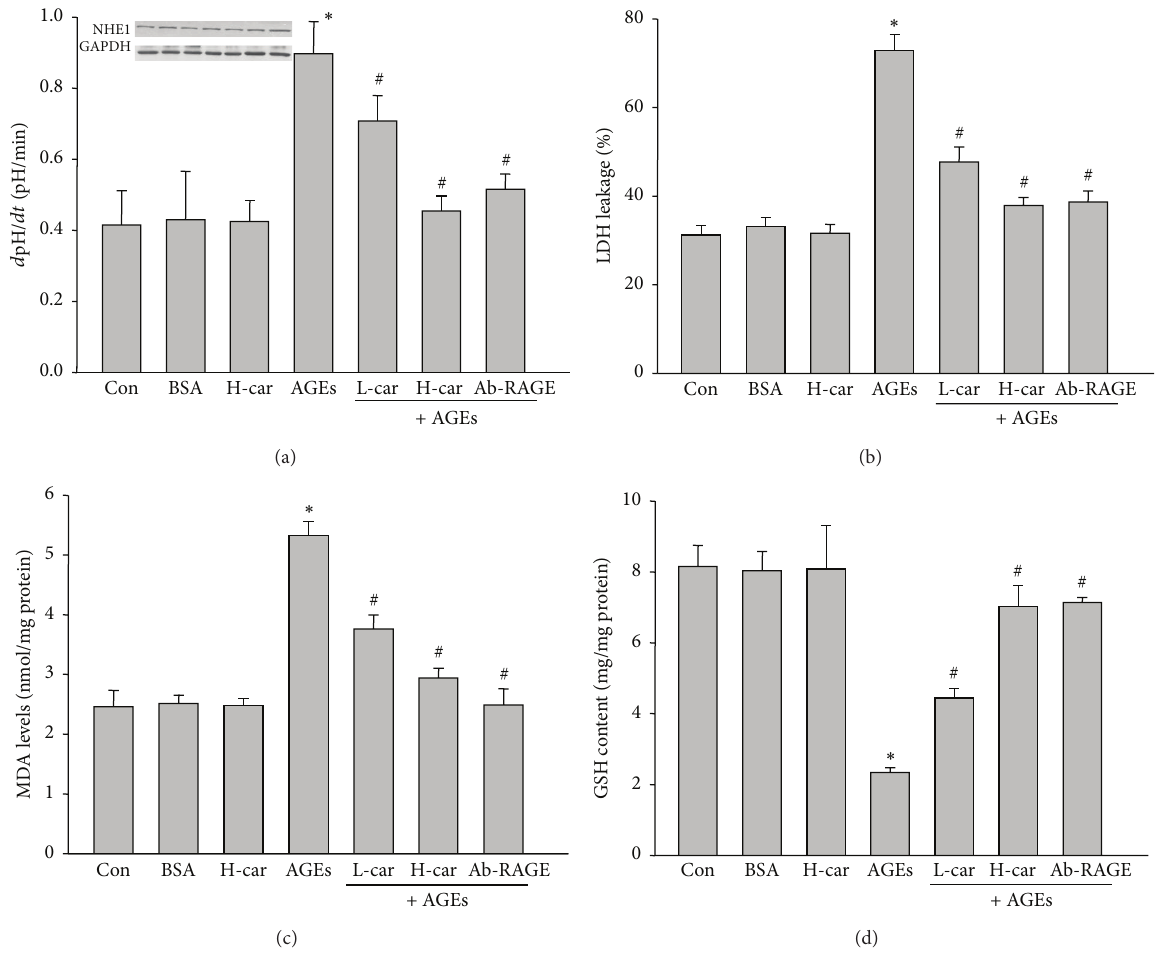
Figure2: Exvivo inhibitionofNHE1bycariporidereversesAGEs-increasedLDHleakageinratrenalcortex.Slicedrenalcortexwasincubated with BSA, H-car (1 𝜇 M cariporide), L-car (0.1 𝜇 M cariporide), and Ab-RAGE (antibody of AGEs receptor). After treatment, (a) LDH leakage and NHE1 protein expression, (b) GSH content, (c) MAD level, and (d) NHE1 activity were measured, respectively. All data were expressed as mean ± SD. 𝑁 is 5 in each group. ∗ 𝑃 < 0.05 versus BSA. # 𝑃 < 0.05 versus AGEs